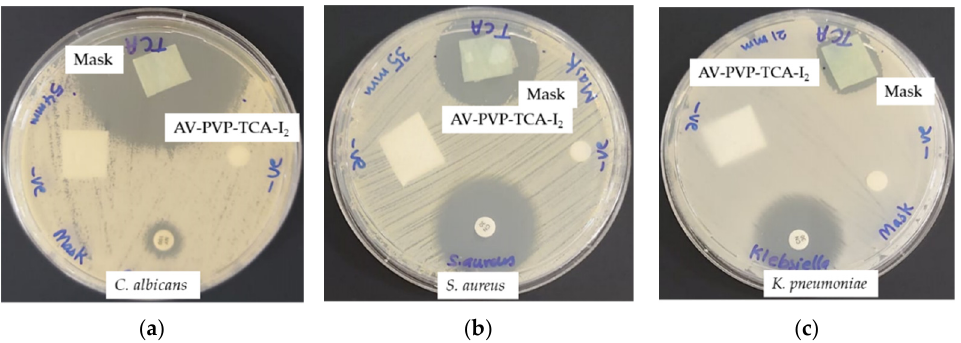
Figure 11. Impregnated sterile masks with AV-PVP-TCA-I 2 . with positive control antibiotic nystatin (NY = 100 IU) and gentamicin (G = 30 µg/disc). From left to right: AV-PVP-TCA-I 2 (11 µg/mL) against ( a ) C. albicans WDCM 00054; ( b ) S. aureus ATCC 25932; ( c ) K. pneumoniae WDCM 00097.